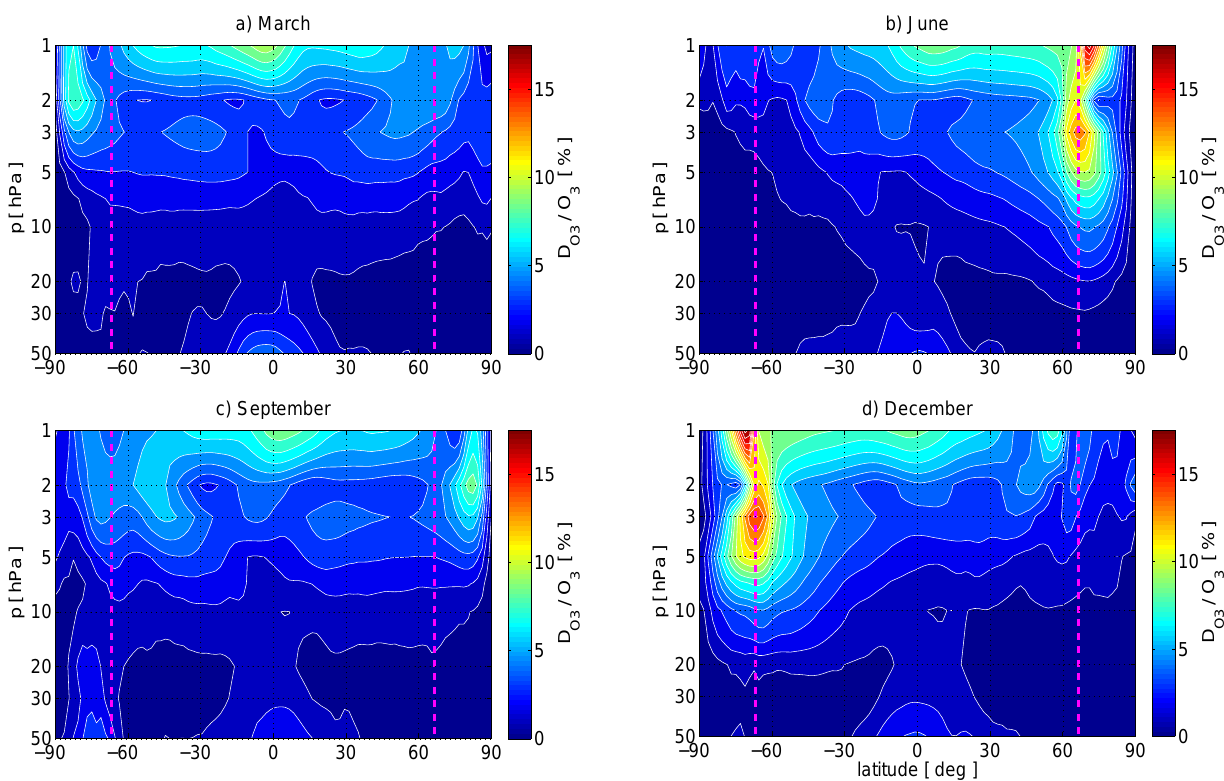
Figure 3. Same as Figure 2 but derived from WACCM for the year